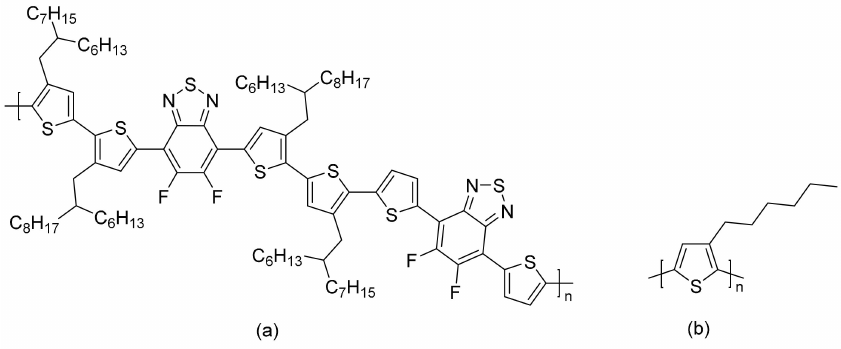
Figure 12. Structures of donor polymers ( a ) PffBT-T3; ( b ) poly(3-hexylthiophene)